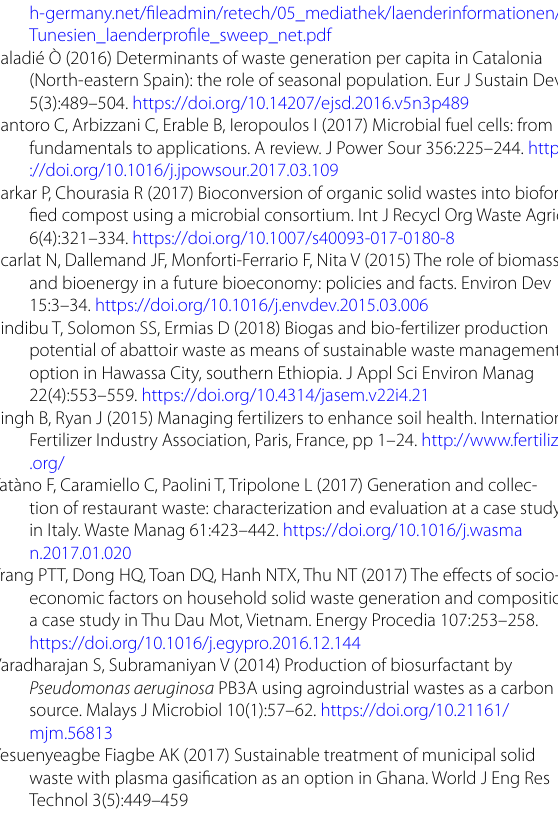
figuration. Waste Manag 73:332–341. https ://doi.org/10.1016/j.wasma